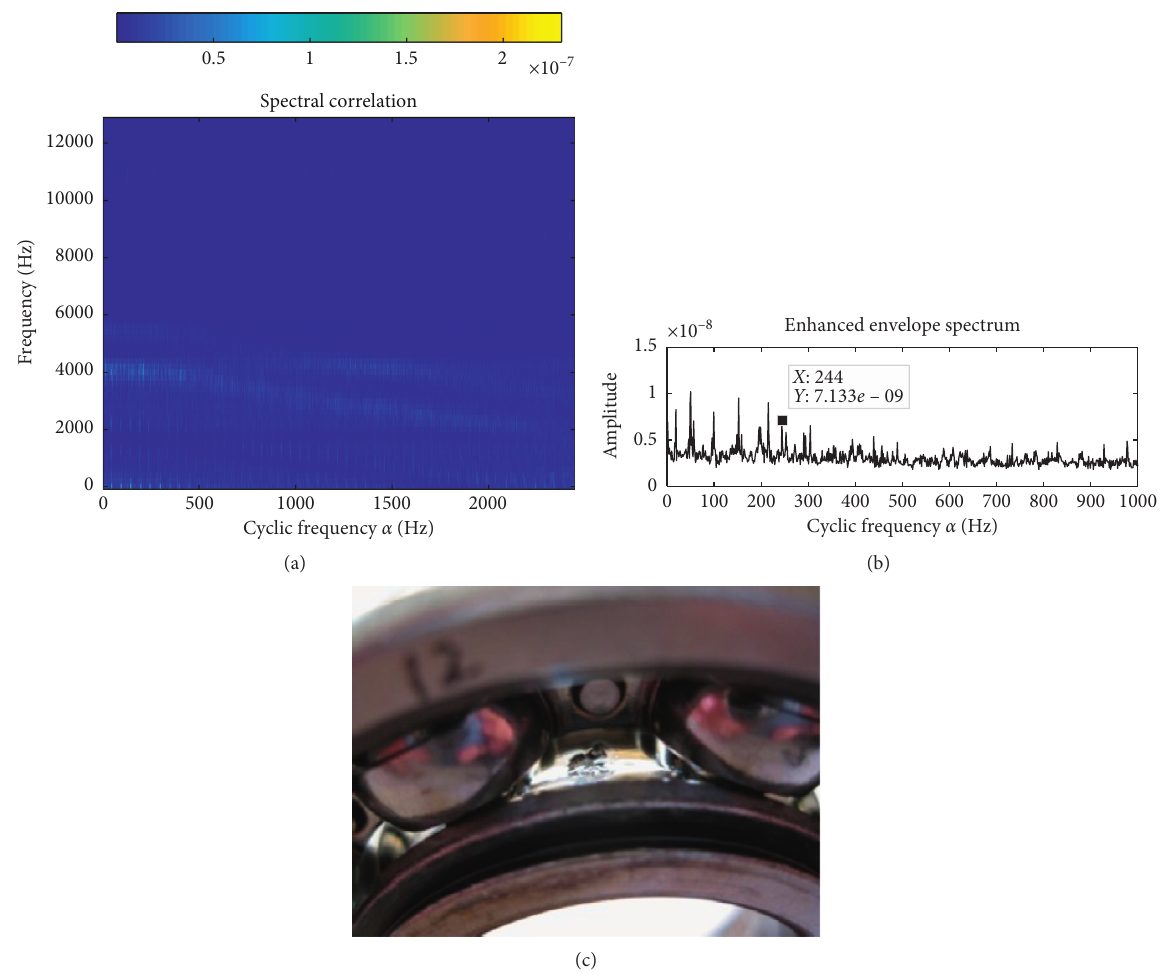
Figure 7: FSC image and EES of the signal as shown in Figure 6(c): (a) FSC image of the signal as shown in Figure 6(c); (b) EES of the signal as shown in Figure 6(c) by using the obtained FSC image as shown in Figure 7(a); (c) actual fault position of the testing